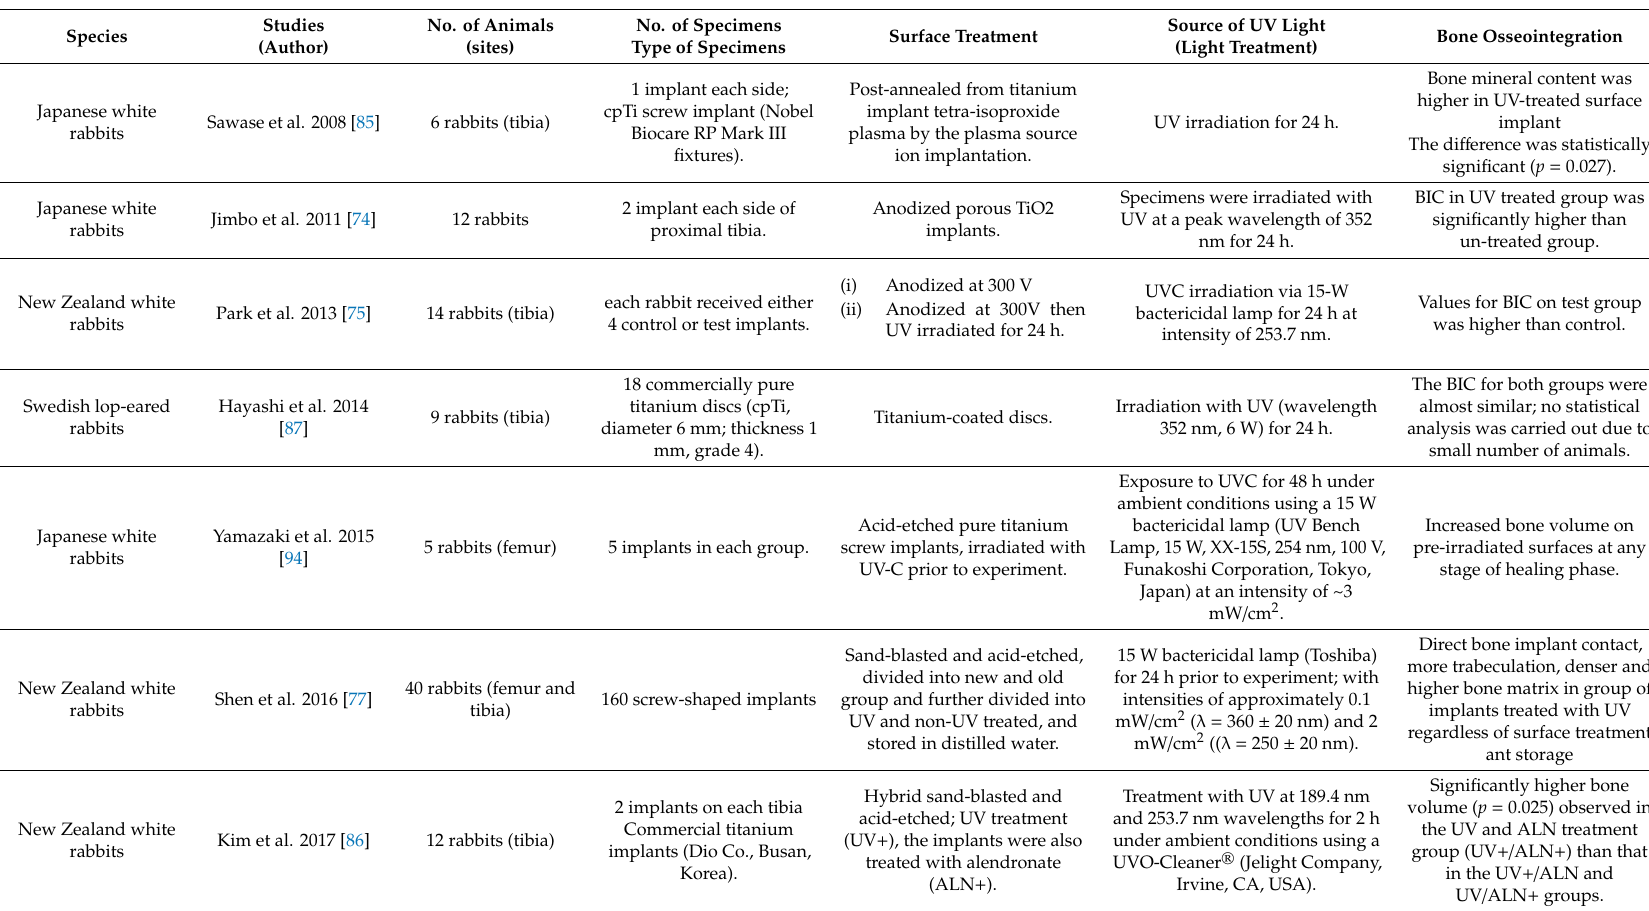
Table 3. E ff ect of UV photofunctionalization on rabbit